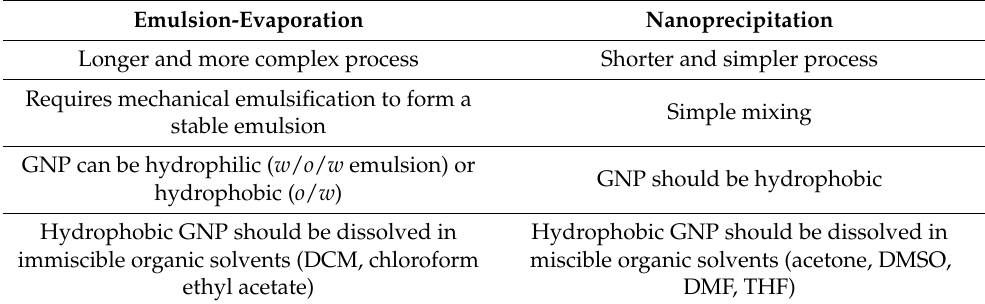
Figure 6. Labeling poly(lactic-co-glycolic acid) (PLGA) nanocarriers with GNP using the w/o/w double emulsion method. Left route: pre-prepared hydrophilic GNP are suspended in the internal aqueous phase. right route: both gold ions (precursor) and the reducing agent are dissolved in the internal aqueous phase. In-droplet reduction and solvent evaporation result in the formation and encapsulation of gold nanoparticles, respectively. Table 1. Comparison between the two major methods to prepare PLGA nano/micro particles.